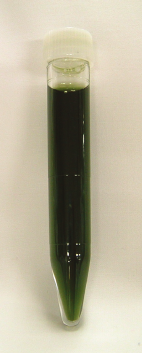
Figure 1: The urine became green after propofol infusion.